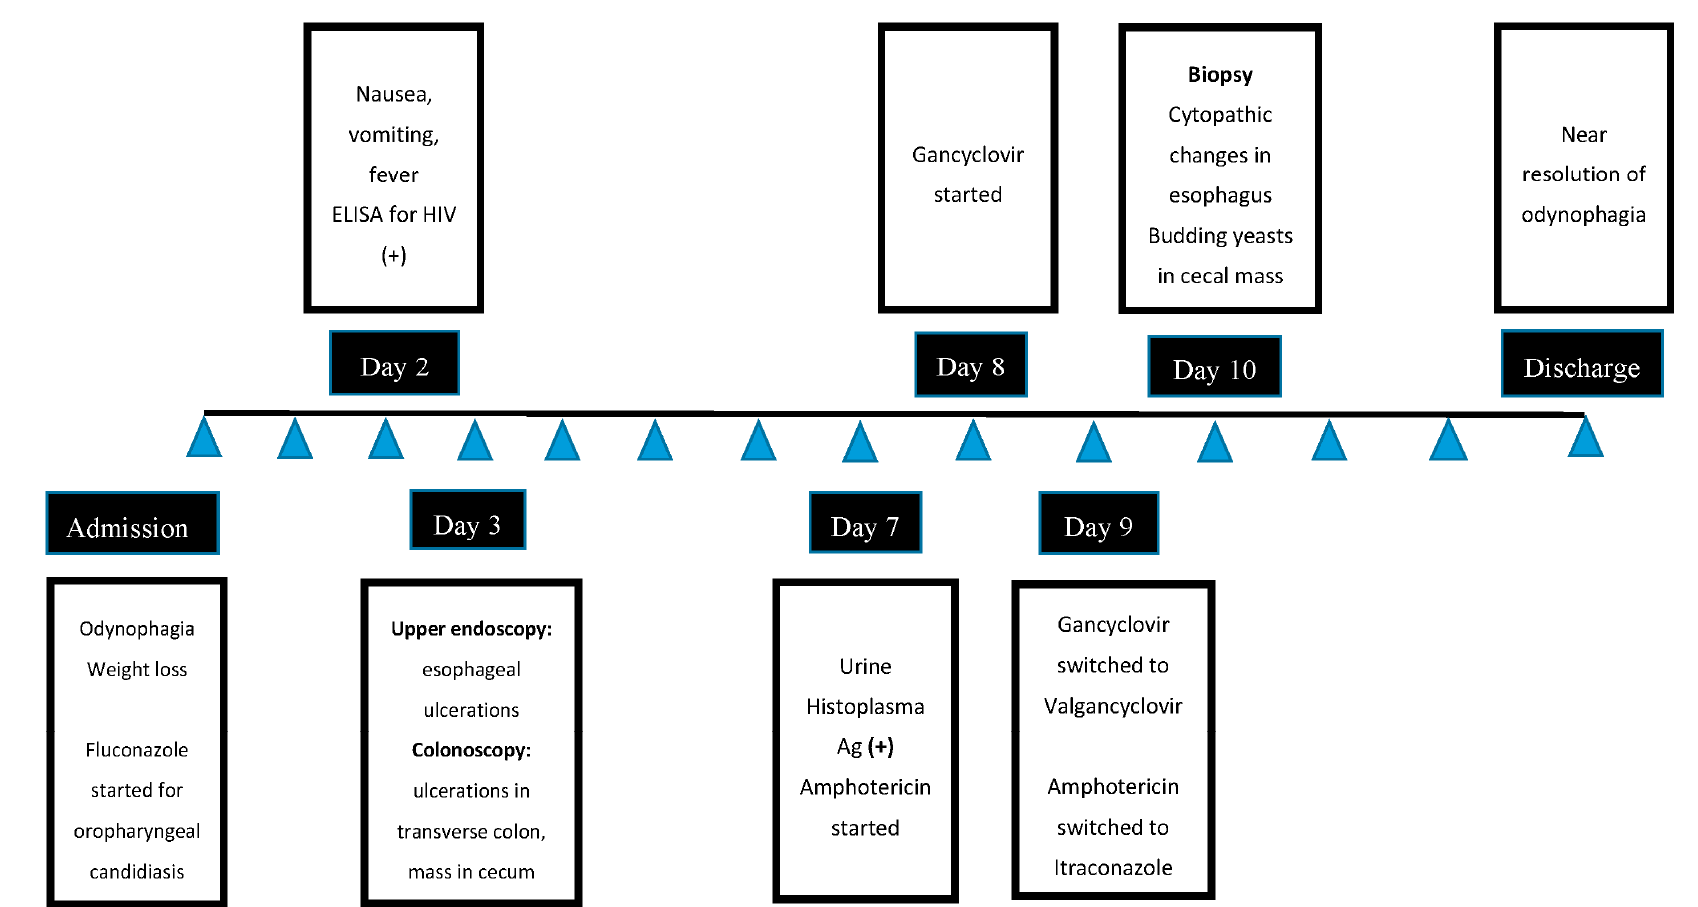
Figure 5. Flowchart of hospitalization course.